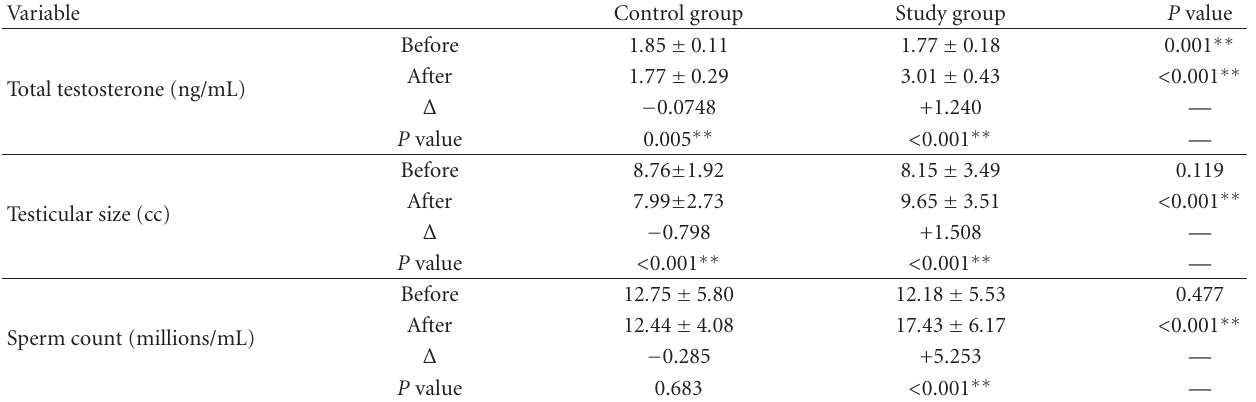
Table 7: Comparisons of change in testicular size, sperm count, and total testosterone levels before and after surgery among the study group and control